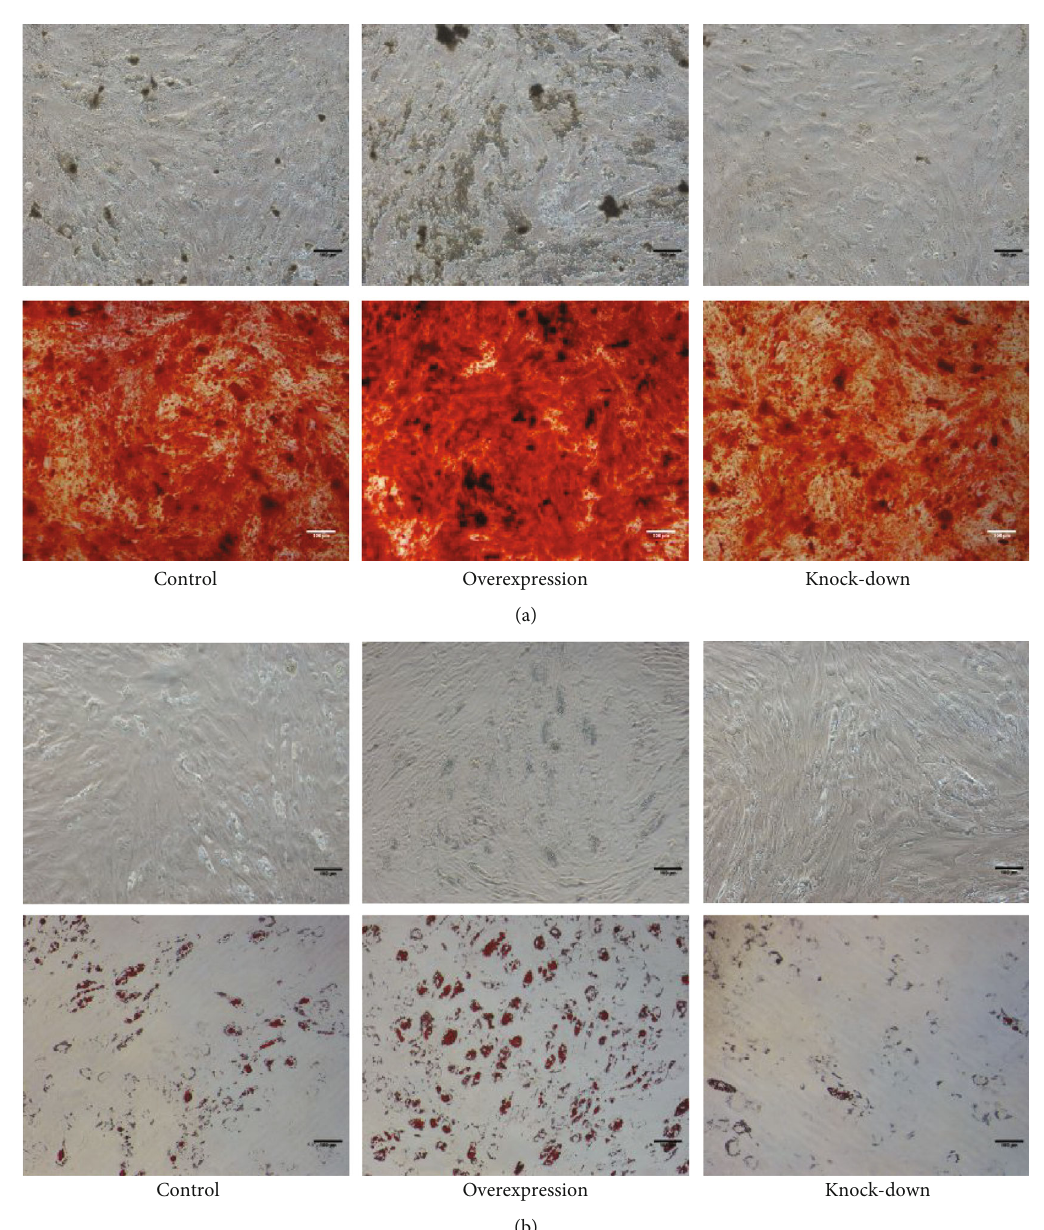
Figure 4: The osteogenic and adipogenic di ff erentiation potential of di ff erent groups of BM-MSCs. (a) Alizarin Red staining was used to detect the osteogenic di ff erentiation of three groups of BM-MSCs, and the density of calci fi ed deposits was used to evaluate the level of osteogenic di ff erentiation. Scale bar = 100 μ m . (b) Oil red O staining was used to evaluate adipogenic di ff erentiation of three groups of BM-MSCs, and the area of lipid droplets was used to measure the level of adipogenic di ff erentiation. All experiments were repeated at least three times. Scale bar = 100 μ m